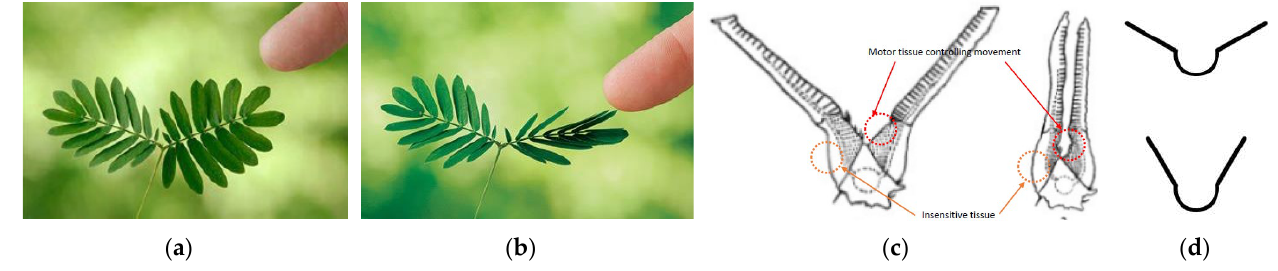
Figure 9. Mimosa pudica plant leaflets: ( a ) normal position, ( b ) closing position when touched. ( c ) Rapid movement controlled by motor tissue. ( d ) Line sketch mimicking the plant. Photos: ( a , b ) [29], ( c ) [30], and ( d ) [31].